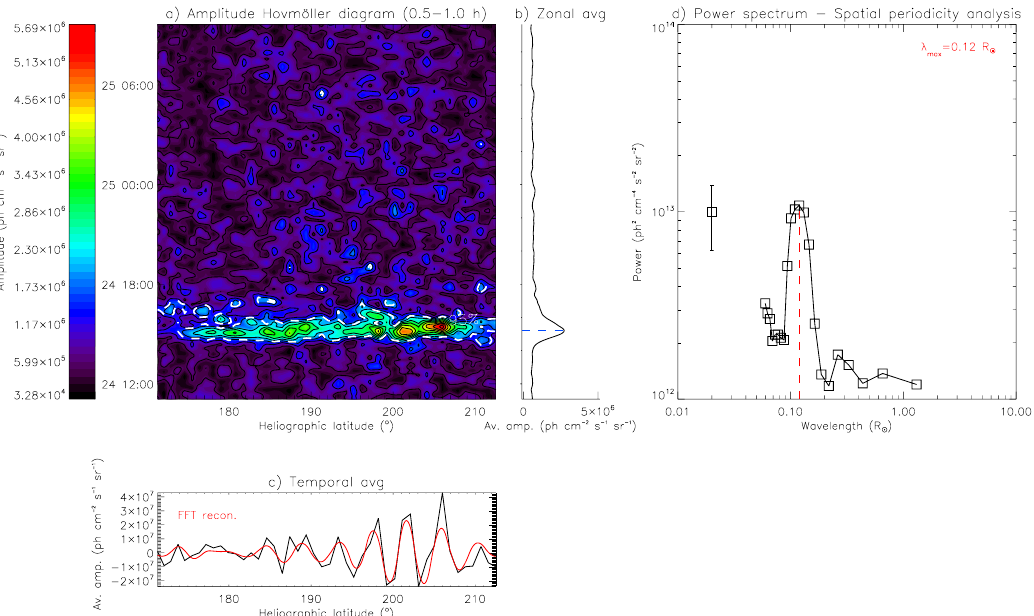
Figure 4. ( a ) Hovm (cid:220) oller amplitude diagram of the wavelet amplitude of the H I Ly α intensity average over the periodicity band of 0.5–1 h, | W ( φ i , t )| (Equation (4)) at each latitude; the left axis is time; the bottom axis is heliographic latitude; the thick dashed contour is the 95% confidence level, using the corresponding white-noise background spectrum at each latitude. ( b ) Average of ( a ) over all latitudes; the blue dashed line indicates the time (15:14 UT) of the first peak in the H I Ly α intensity. ( c ) Average of ( a ) over the time interval from t 1 = 14:42 UT to t 2 = 15:30 UT on 24 December 2006, filtered out with a 6-point running average to remove the latitude dependence at large scales; the red curve is the Fourier reconstruction of the time series obtained with the dominant spatial mode inferred from the Fourier power spectrum of ( c ). ( d ) Fourier power spectrum of ( c ): the dominant spatial scale of 0.12 R (cid:12) is indicated by a red dashed